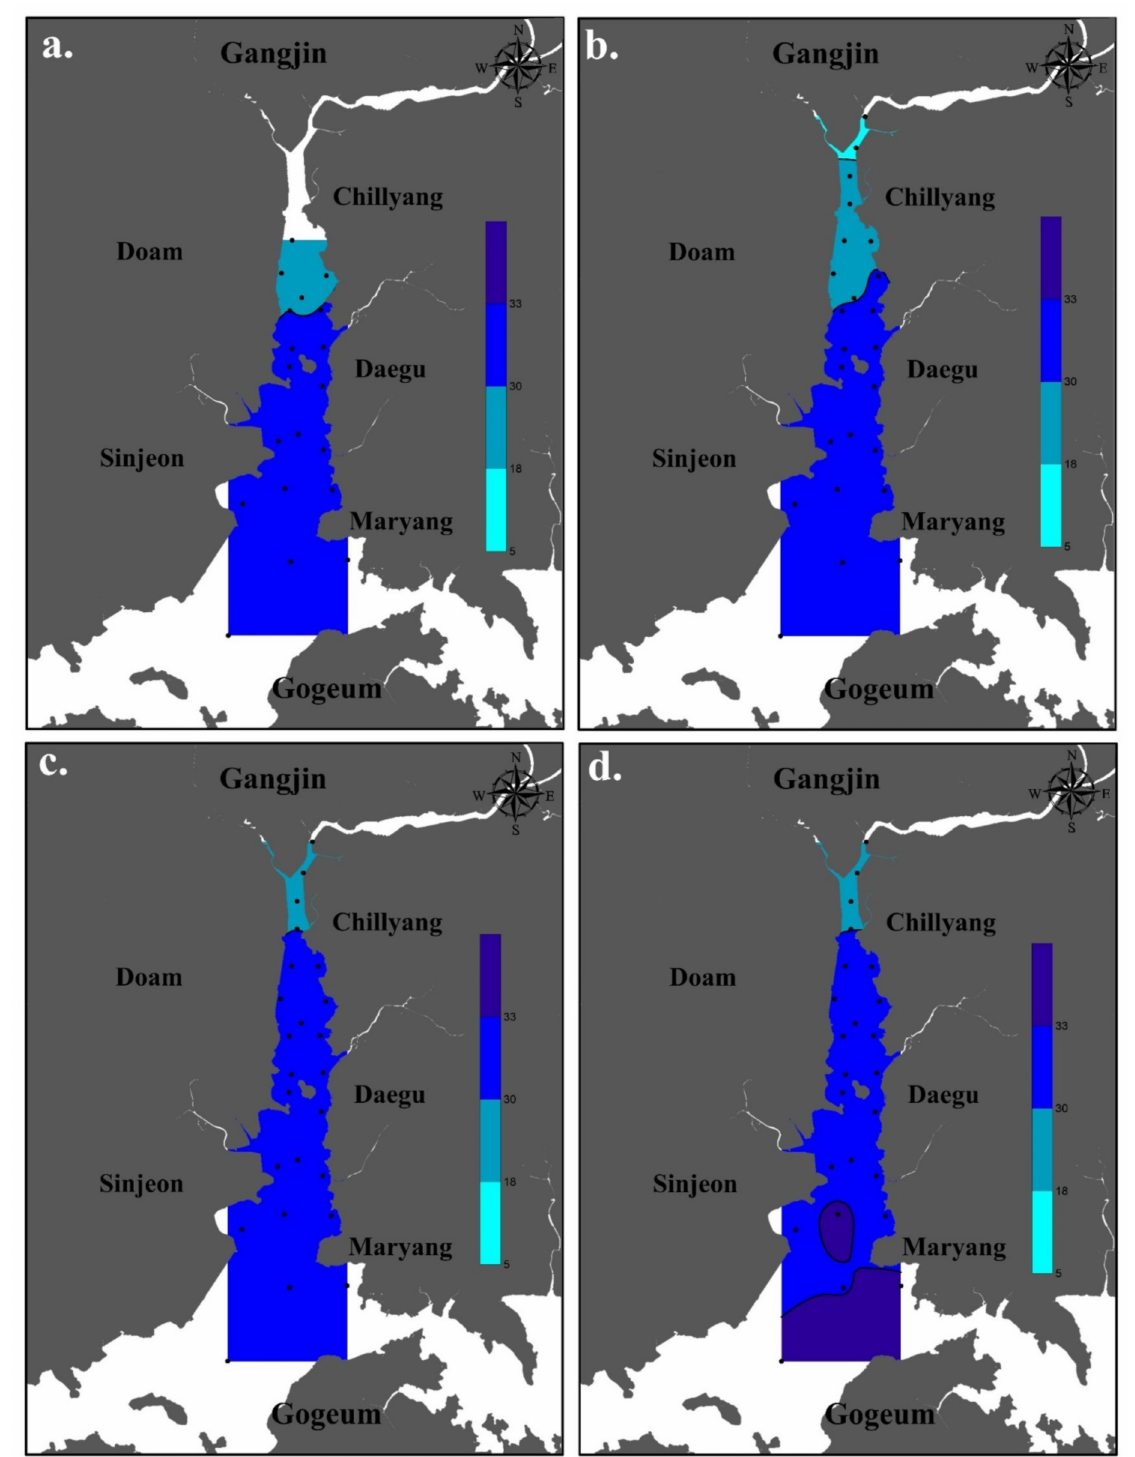
Figure 3. Horizontal distribution of surface salinity (psu) during the study period: ( a ) spring, ( b ) summer, ( c) fall, ( d ) winter. The different colors in the figure, from light blue to dark blue, indicate the mesohaline (5–18 psu), polyhaline (18–30 psu), and euhaline (30–40 psu) zones,